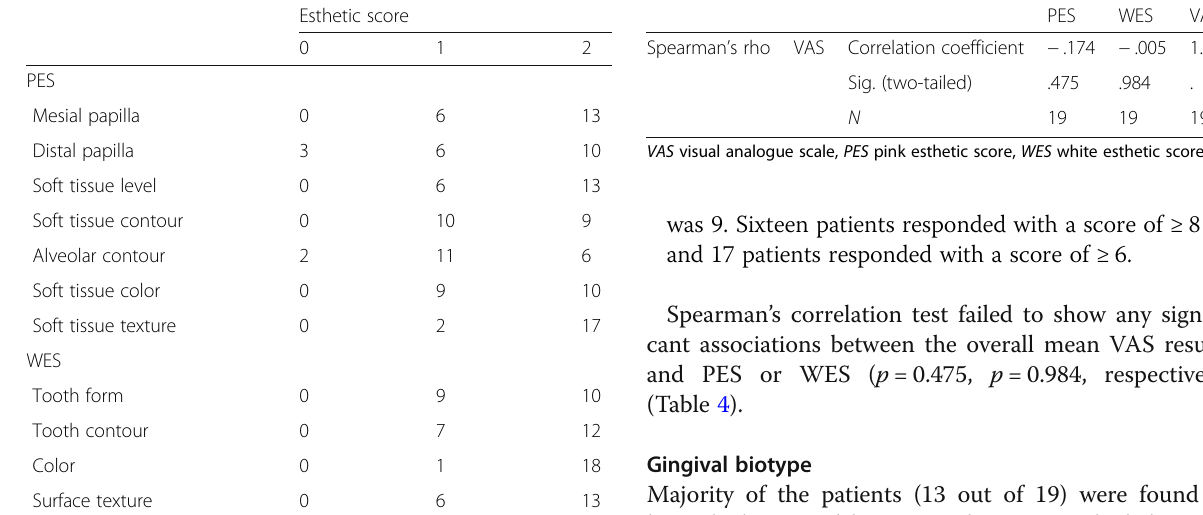
Table 4 Spearman ’ s correlation test between VAS and PES or